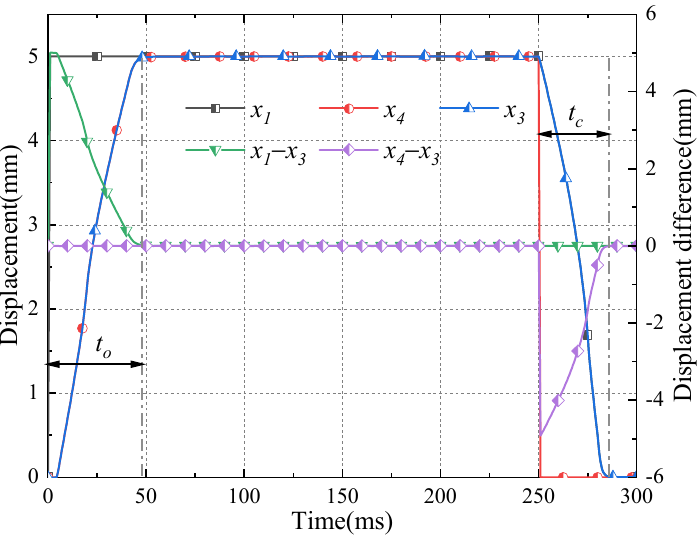
Figure 14. The step response characteristics of the valve under full stroke. Figure 15 shows the relationship between the flow force of the poppet valve and the valve opening under the step response of the proportional valve. The direction of the flow force is along the direction of the closing process of the main inlet valve, which is the same direction with the main spring force. When the supply flow remains constant, the flow force increases linearly with the opening of the main inlet valve and then decreases in an inversely proportional trend. It reaches the maximum value when the displacement of the main inlet valve spool is between 1.5–2 mm. This is consistent with the conclusion in the literature [25].